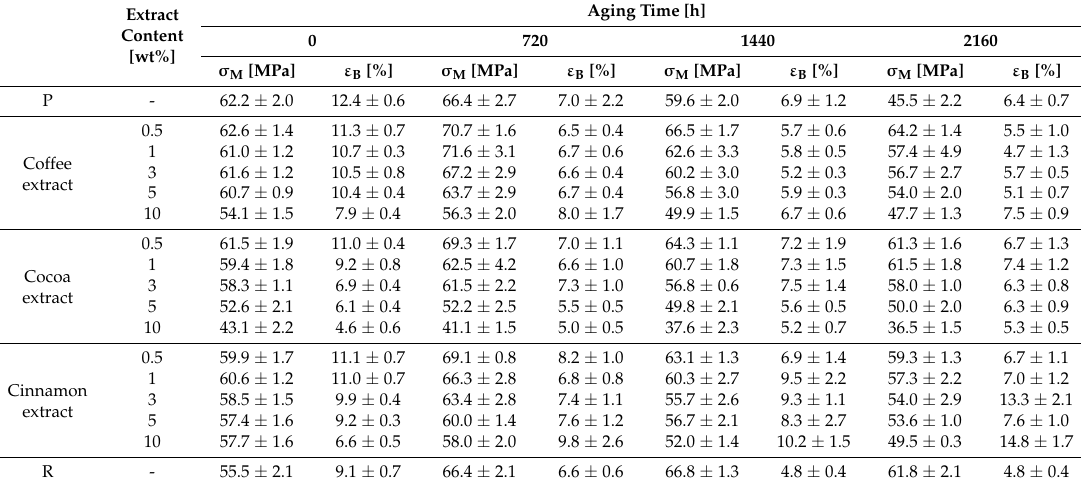
Table 4. Results of the tensile